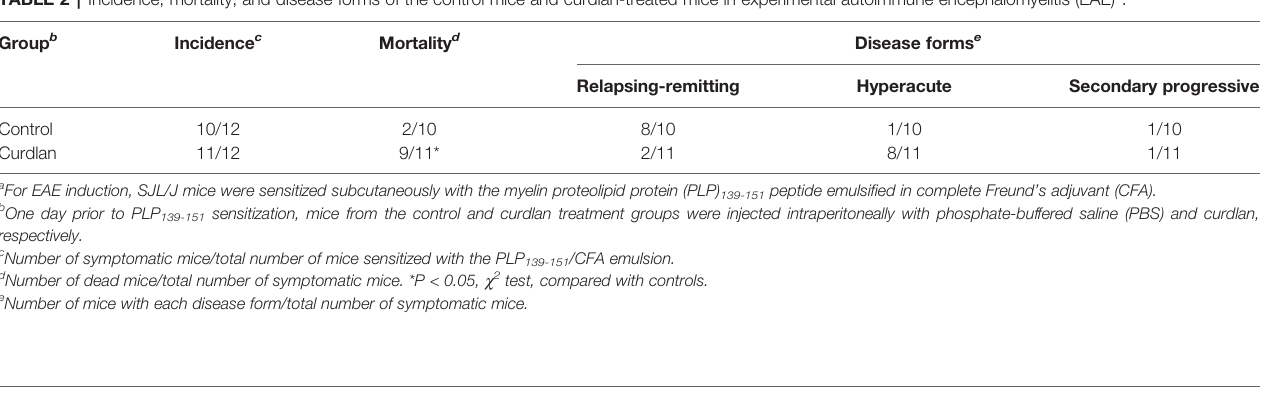
TABLE 2 | Incidence, mortality, and disease forms of the control mice and curdlan-treated mice in experimental autoimmune encephalomyelitis (EAE) a .